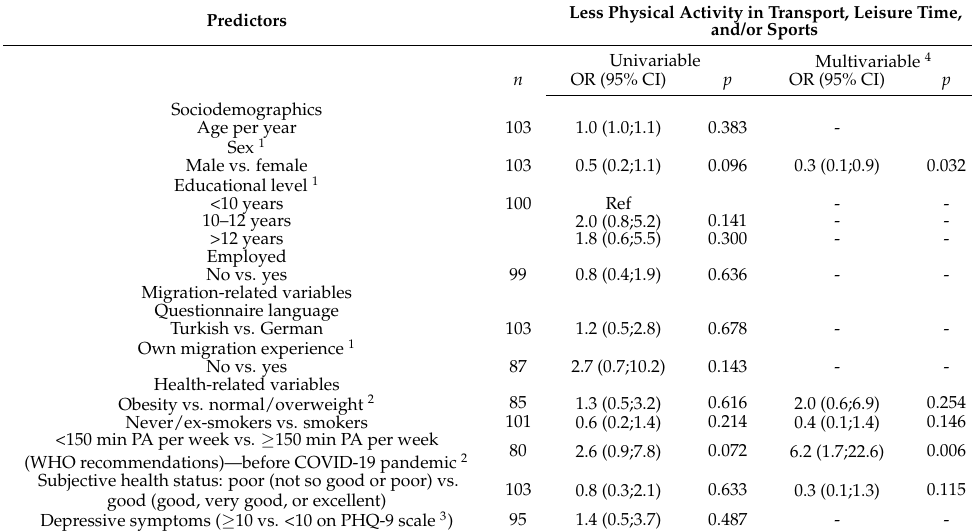
Table 2. Univariable and multivariable regression analysis for the outcome less physical activity during the COVID-19 pandemic.